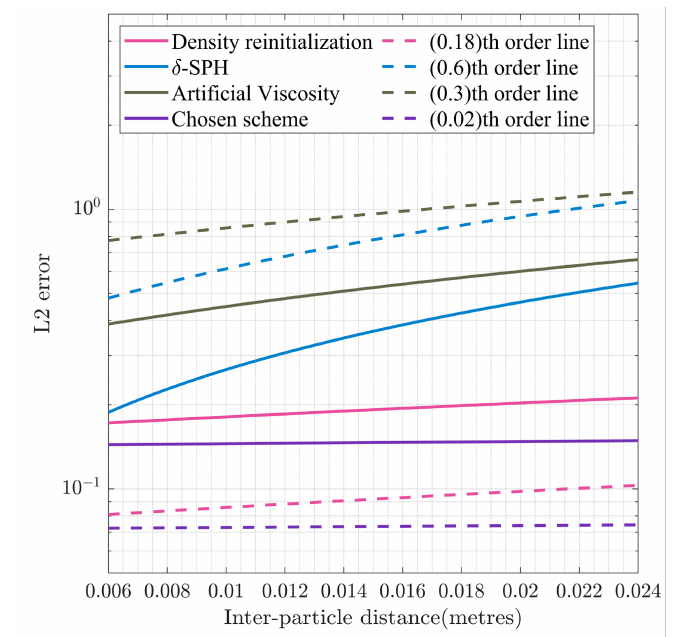
Figure 4. The computed L2 error for the grid study interpolated over the range of particle reso- lution shown for the different numerical dissipation schemes used for the dam break simulation. Different order lines have been provided to aid in the interpretation of the convergence rates for the dissipation